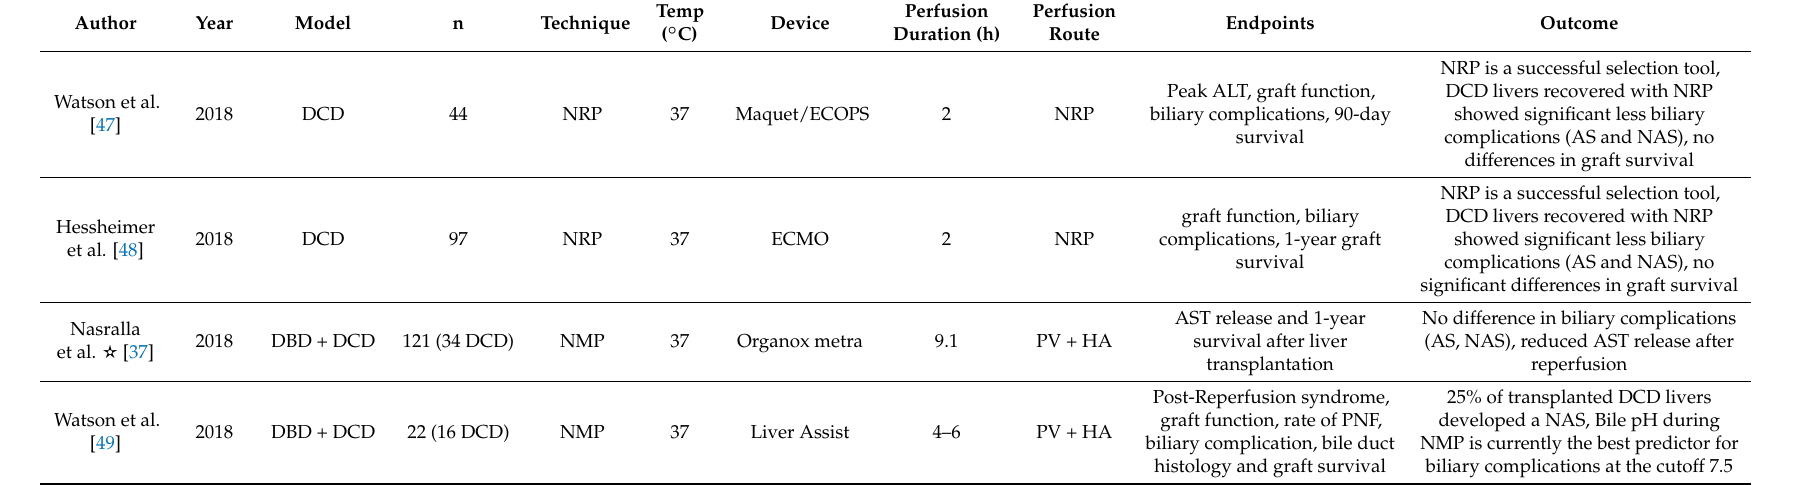
Table 2. Impact of machine perfusion on biliary complications after liver transplantation (clinical studies,